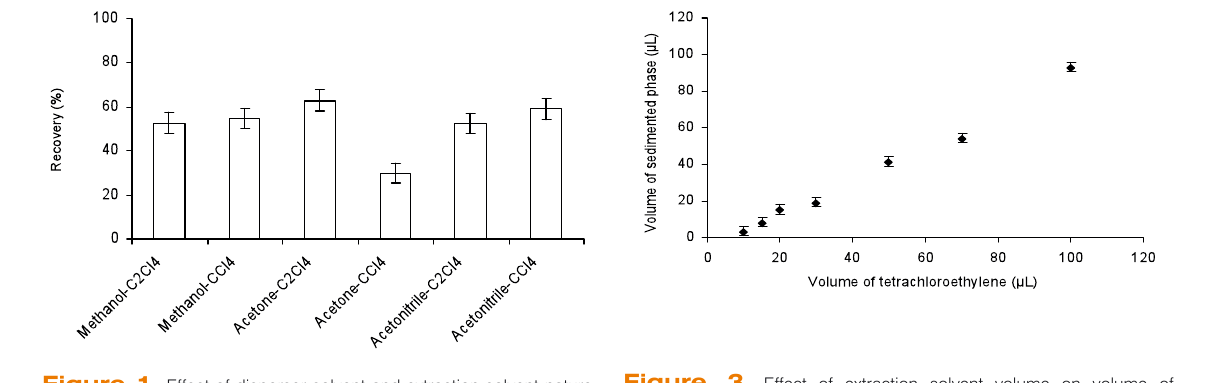
Figure 1. Effect of disperser solvent and extraction solvent nature on extraction recovery (analyte concentration 1 mg L -1 , volume of disperser solvents and extraction solvents were 1 mL and 50 µL, respectively, pH = 3, n = 3).